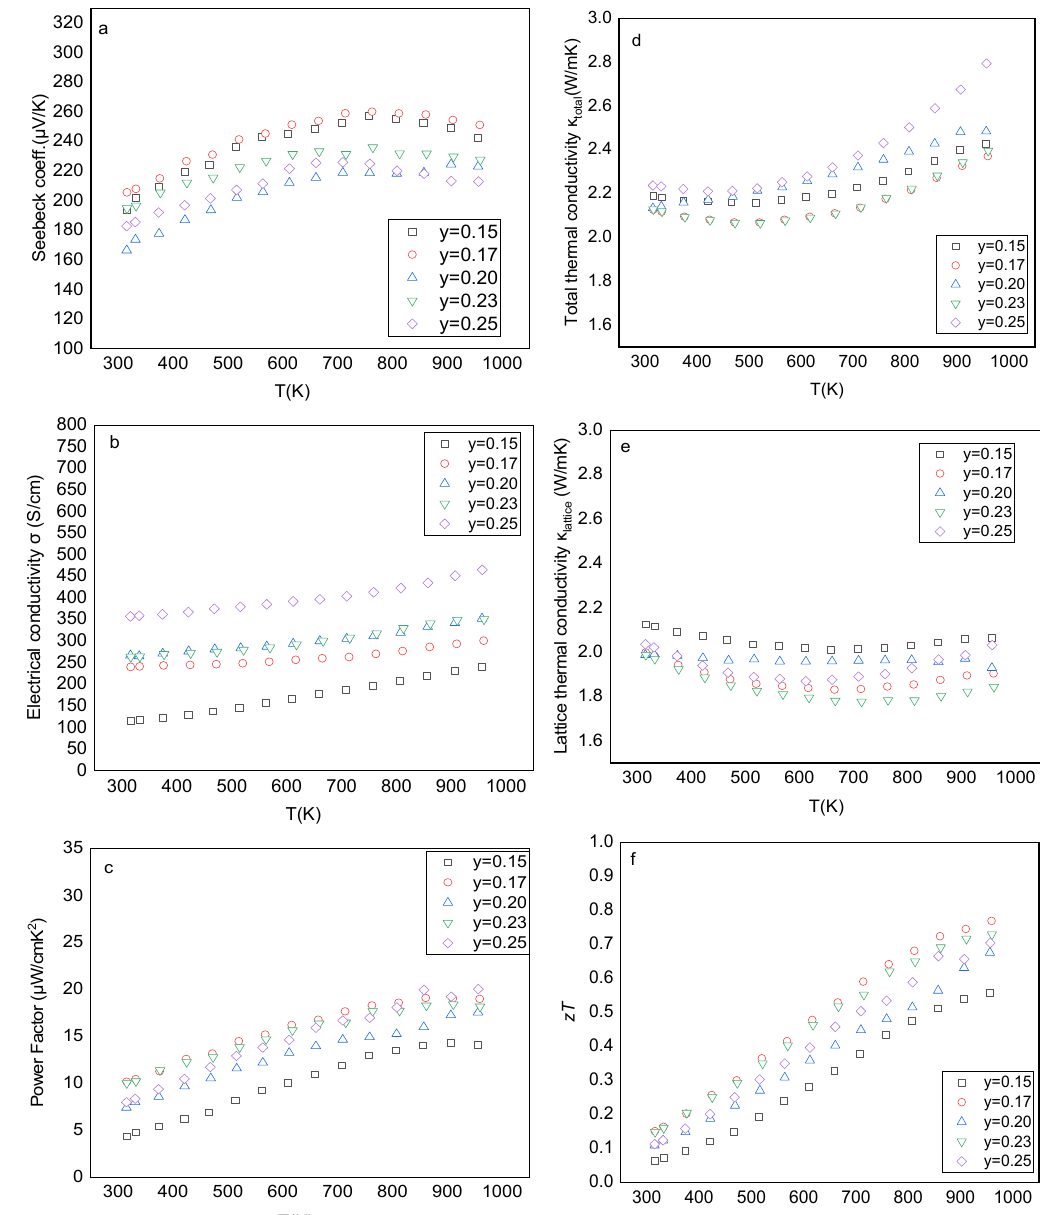
Figure 7. Temperature-dependent Seebeck coefficient ( a ), electrical conductivity ( b ), Power factor